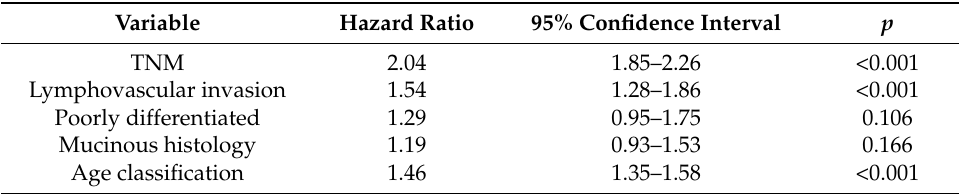
Table 4. Multivariate analysis for overall